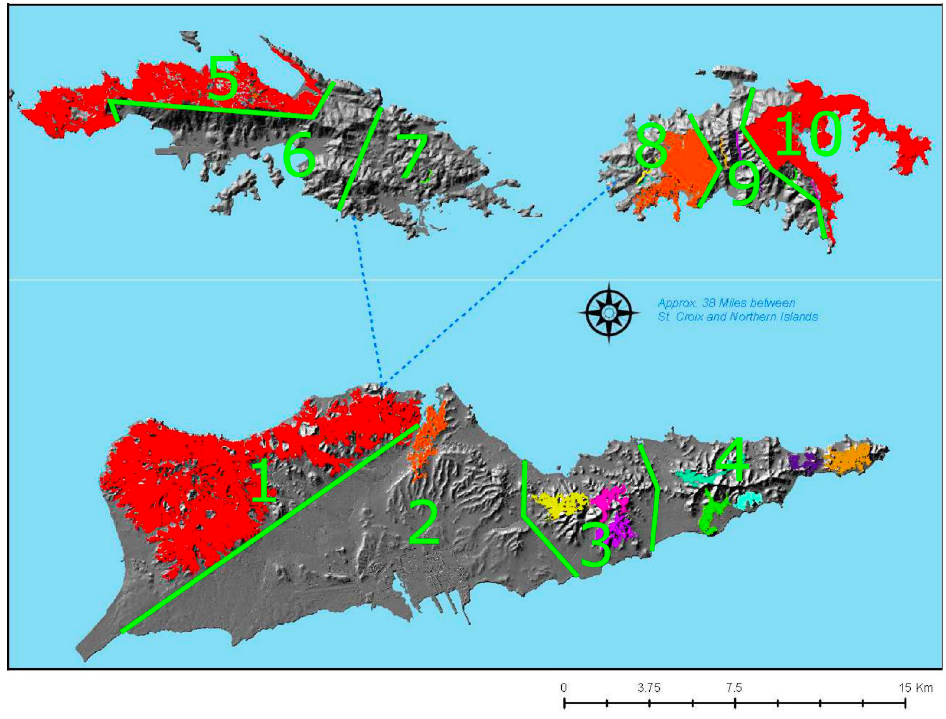
Fig 2. USVI mongoose sampling regions (n = 10) for determination of rabies freedom, with contiguous forest regions highlighted. This figure was adapted from Chakroff, Virgin Islands Department of Agriculture [16].